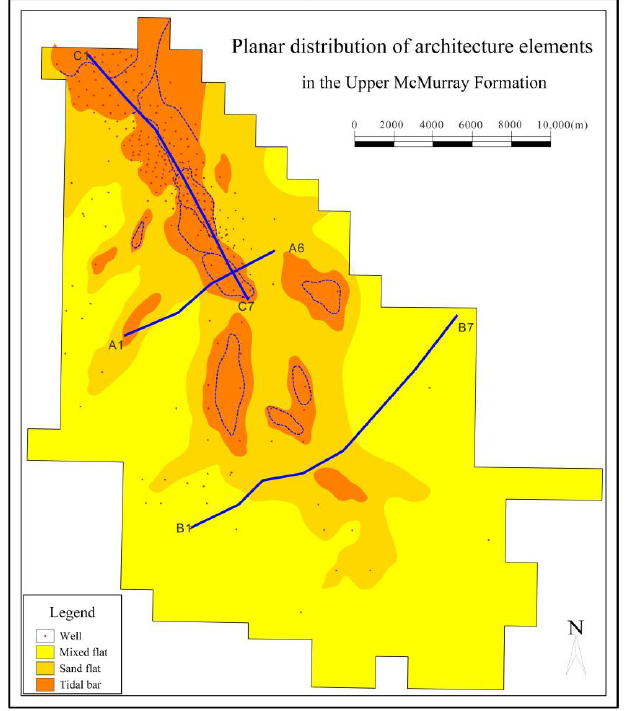
Figure 4. The location of sections in Figures 5 – 7 (A1 – A6 is the location of cross-section 1, B1 – B7 is the location of cross-section 2, and C1 – C7 is the location of longitudinal section.) . And it’s also the planar map of architectural elements in U1-1. The blue dashed lines represent different periods of accretions, the complex of the tidal bar in the incised valley is lateral accretion, and the others are forward accretions.